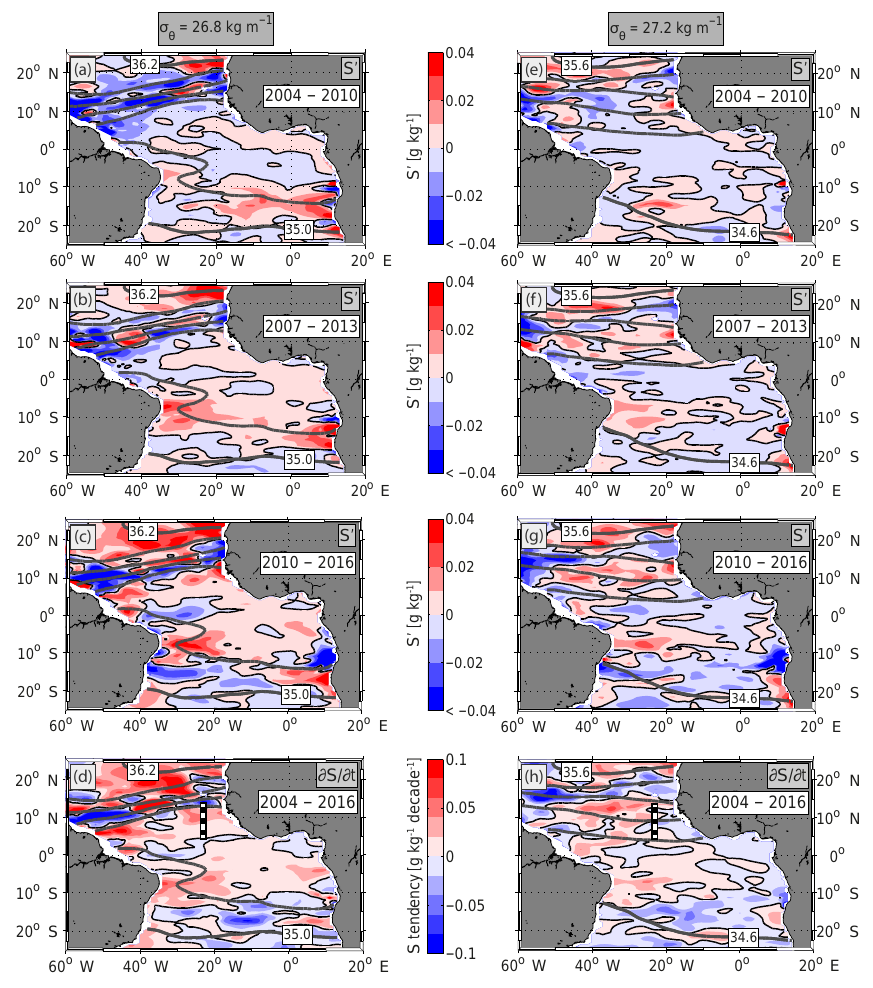
Figure 8. Salinity anomalies (filled contours) in the tropical Atlantic at the isopycnal surface 26.8kgm − 3 from Argo float observations for isopycnal surface 26.8kgm − 3 between 2004 and 2016. The black–white dashed line marks the 23 ◦ W section between 4 and 14 ◦ N for reference. Gray contours in panels (a) to (d) define the mean salinity distribution. Panels (e) to (h) are same as (a) to (d) but for isopycnal surface 27.2kgm − 3